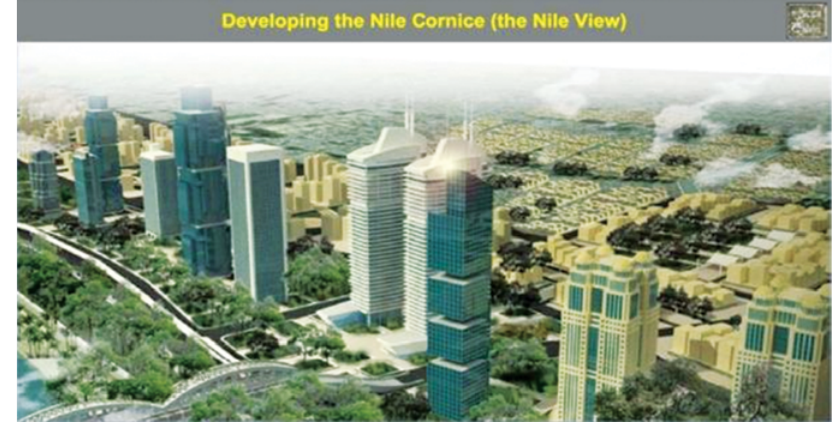
Figure 2. Rendering of the Rod al-Farag Corniche in the Cairo 2050 Plan. Only the identical Nile City Towers on the right exist, behind them is Ramlet